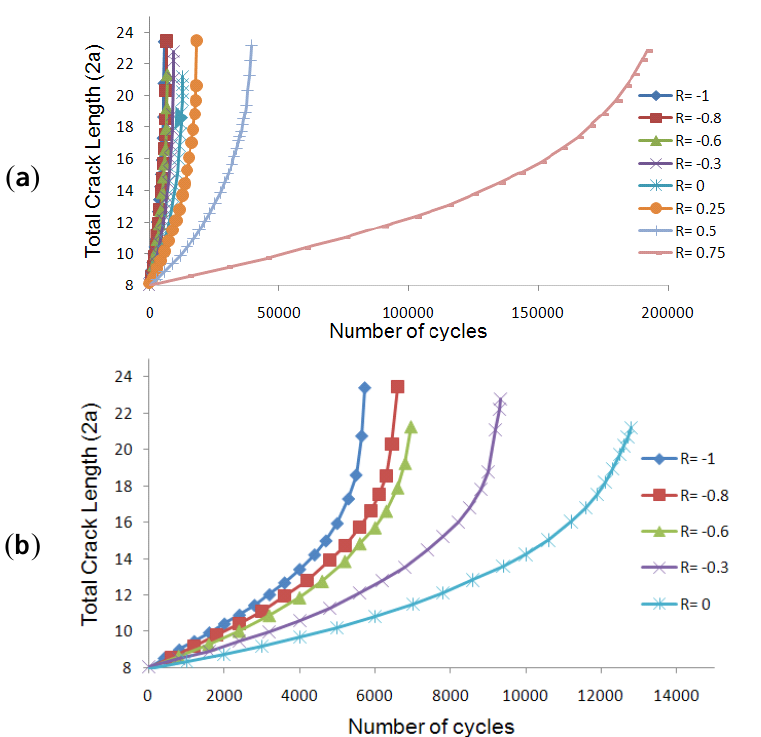
Figure 32. Crack length versus the number of cycles for ( a ) the whole stress ratios; and ( b ) negative stress ratios